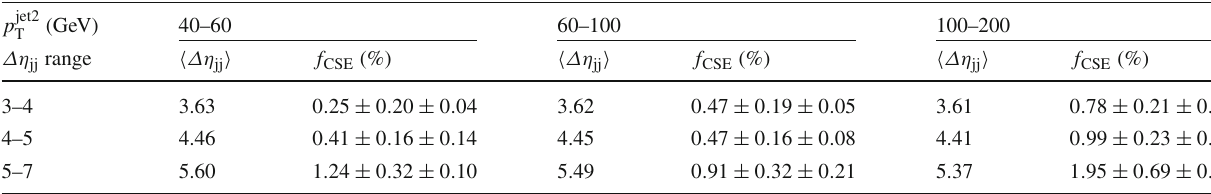
Table 3 Measured values of the fraction of dijet events with a central bins and the rows to Δη jj bins. The first and second errors correspond to the statistical and systematic uncertainties, respectively. The mean gap ( f CSE ) as a function of the pseudorapidity separation between the values of Δη jj in the bin are also jets ( Δη jj ) in bins of p jet2 . The columns in the table correspond to p jet2 T T